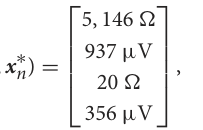
. As resistance cycling progresses, later terms of the + 1